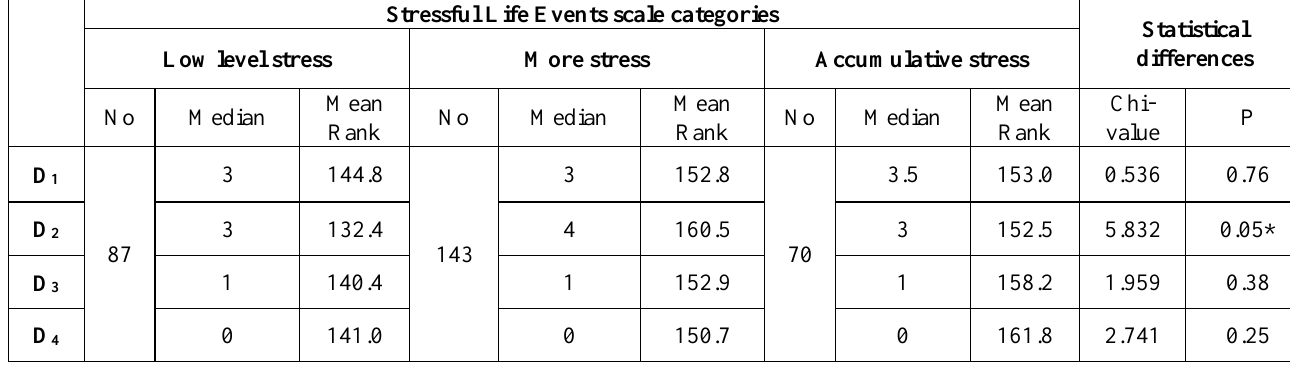
Table (2): Caries experience represented by grades of Lesion severity (D according to categories of Stressful Life Events scale .